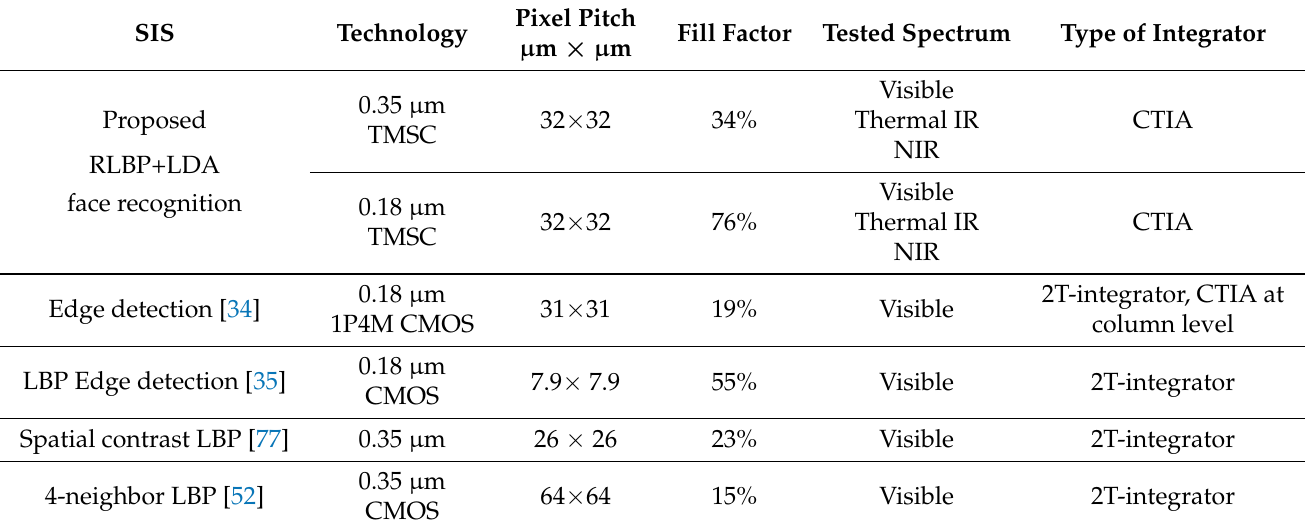
Table 1. Comparison of our smart-pixel design to other circuits in the